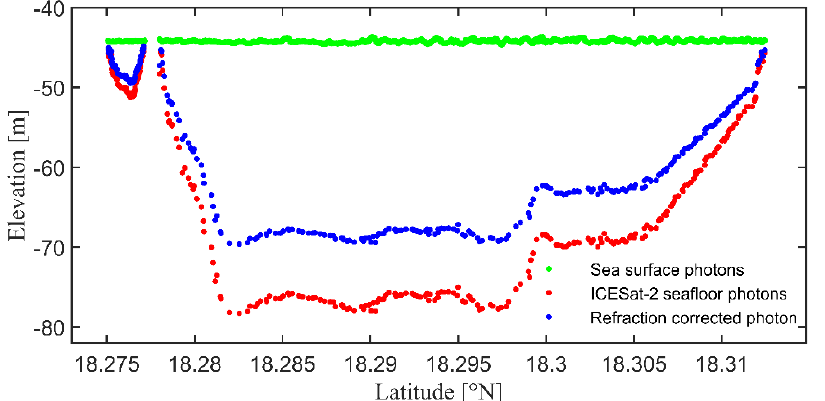
Figure 9. The raw photon point cloud of ATL03 for 20190221GT1L in the St. Thomas area.